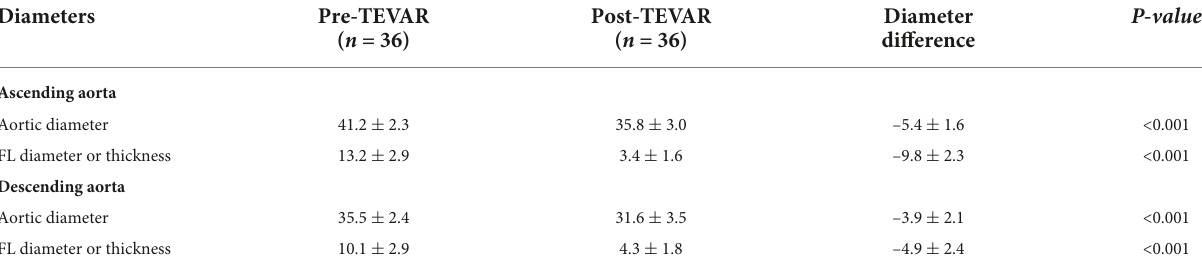
TABLE 4 Aortic diameters of the 36 patients before and after thoracic endovascular aortic repair (TEVAR) for primary retrograde type A aortic